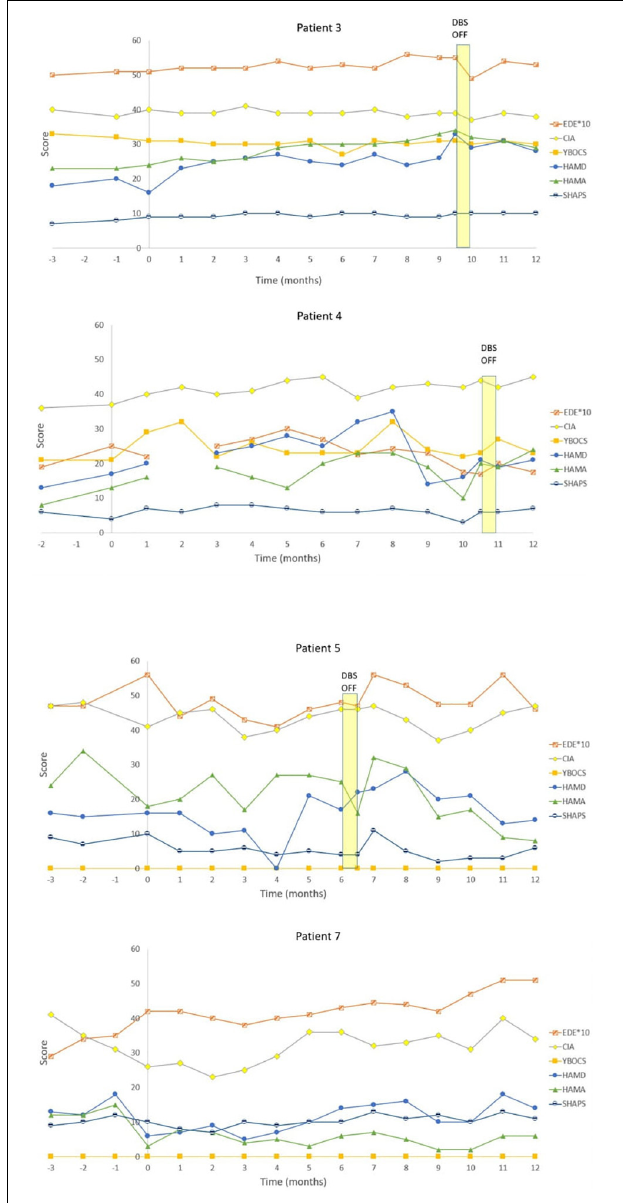
FIGURE 3 | Individual graphs for Non-responders: Patients 3, 4, 5, and 7. Eating Disorder Examination (EDE) X 10 for graphical purposes, Yale-Brown-Cornell Eating Disorder Scale (YBC_EDS), Hamilton Depression Scale (HAMD), Hamilton Anxiety Scale (HAMA), Snaith-Hamilton Pleasure Scale (SHAPS): Yale-Brown Obsessive-Compulsive Scale